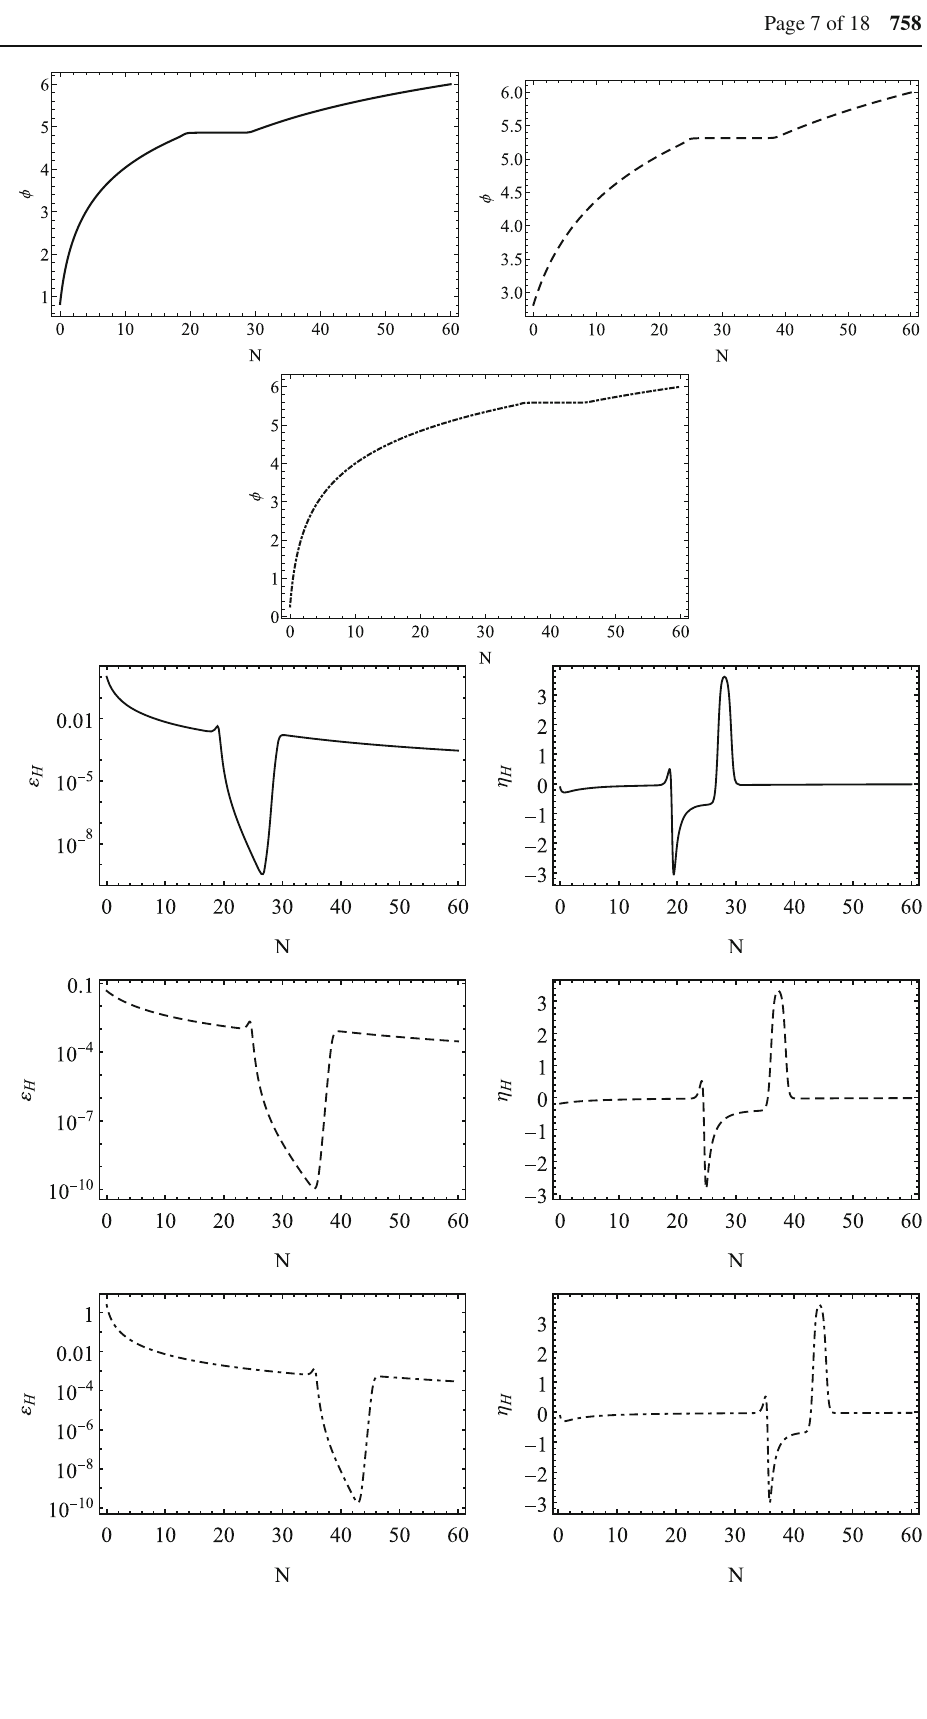
Fig. 2 Evolution of the first slow-roll parameter ε H (left) and the second slow-roll parameter η H (right) versus the e -fold number N for Case 1 (solid line), Case 2 (dashed line), and Case 3 (dash-dotted